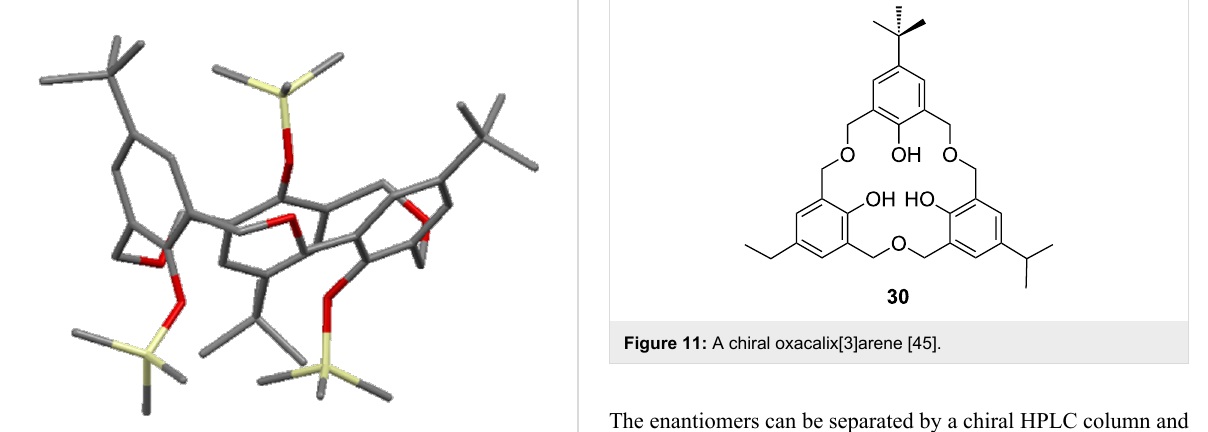
The enantiomers can be separated by a chiral HPLC column and give opposite circular dichroic spectra, and can be crystallized out for structural characterization. X-ray crystallography was again able to determine the structure of compound 30 (Figure 12).